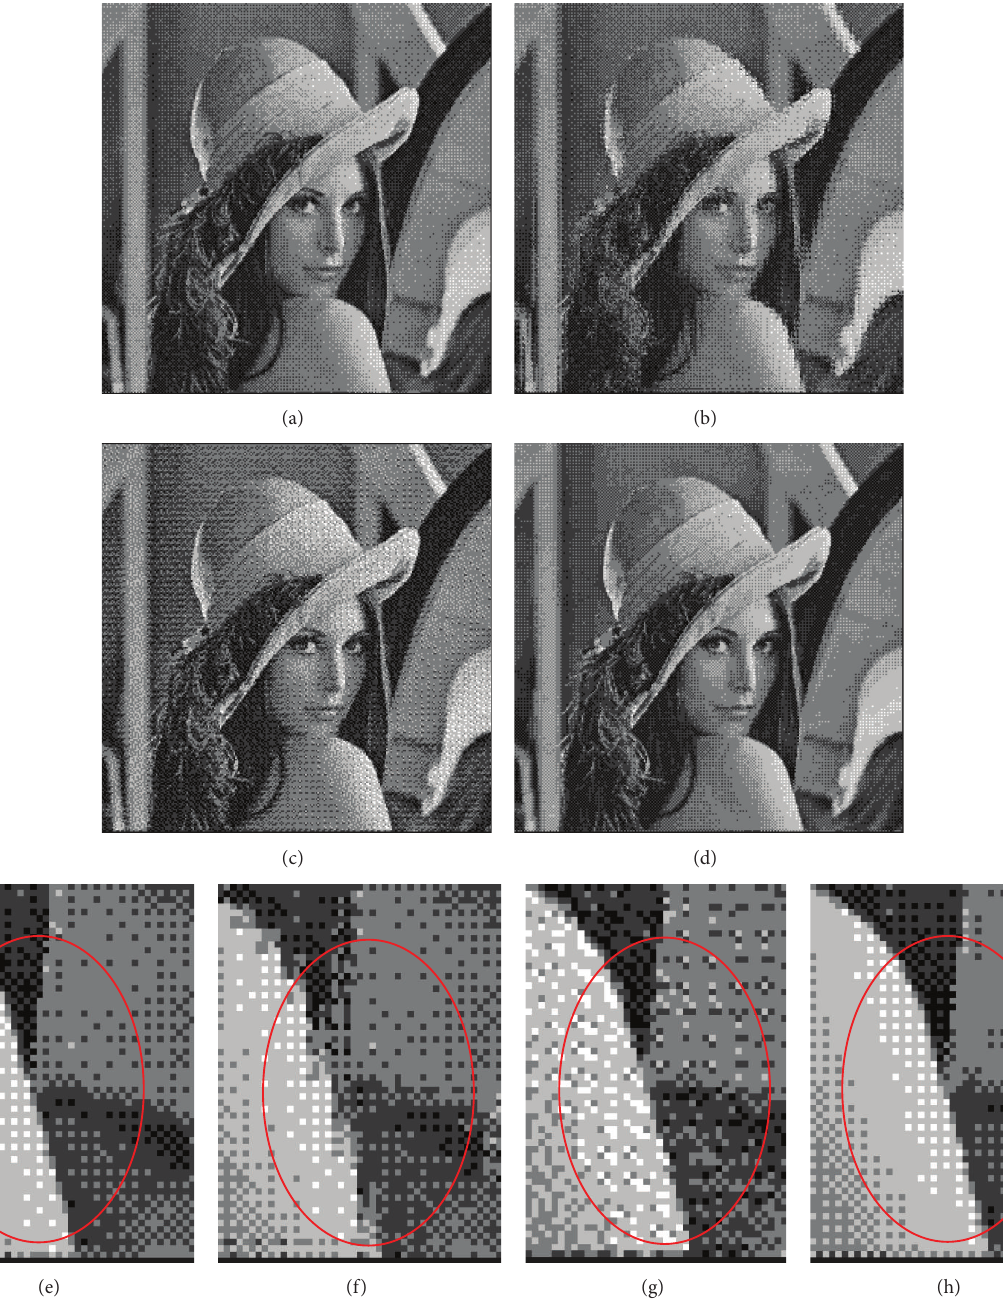
Figure 8: Visual quality comparison with 128 embedding bits when 𝑛 = 8 . (a) Original dithered image. (b) Embedded dithered image using Guo et al.’s method [12]. (c) Embedded dithered image using Hagit’s method [13]. (d) Embedded dithered image using the proposed method. (e) Enlarged partial image of (a). (f) Enlarged partial image of (b). (g) Enlarged partial image of (c). (h) Enlarged partial image of